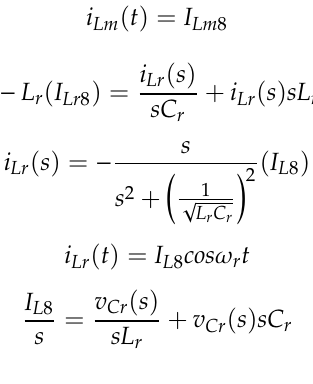
Figure 13. The equivalent circuit of Mode 10 and key waveform.